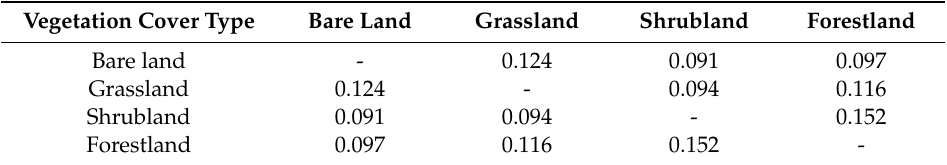
Table 9. Comparison of increase of soil moisture content under di ff erent vegetation cover types based on the Mann–Whitney’s U test with Bonferroni correction ( p -value).